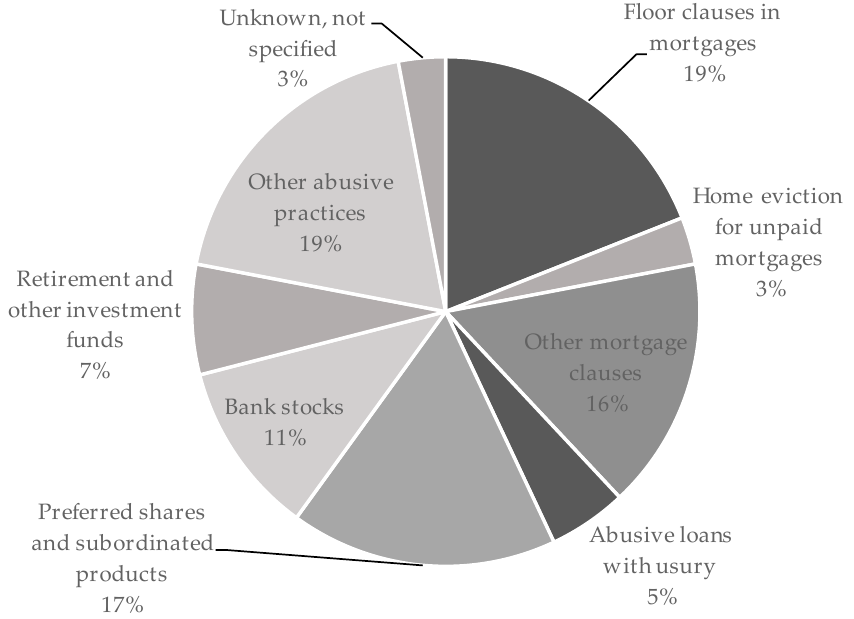
Figure 2. Distribution of financial fraud types as reported in the 2017 Madrid Health Survey ( n = 485).